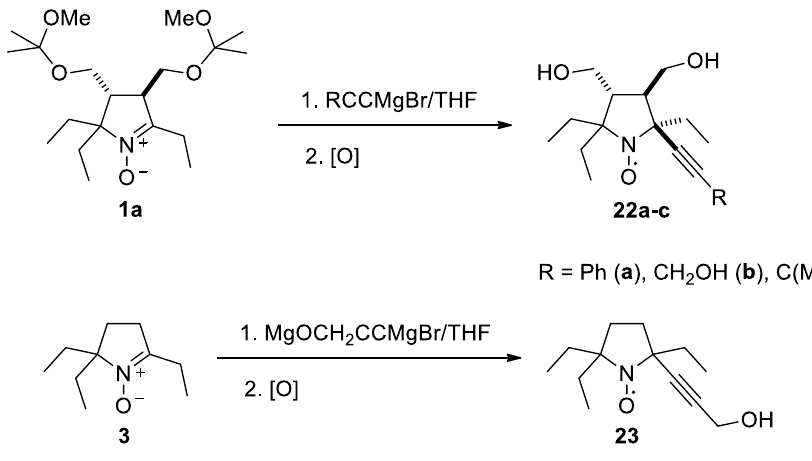
tion of 0.2 mM. Modulation amplitude 0.5 G, MW power 5 mW.